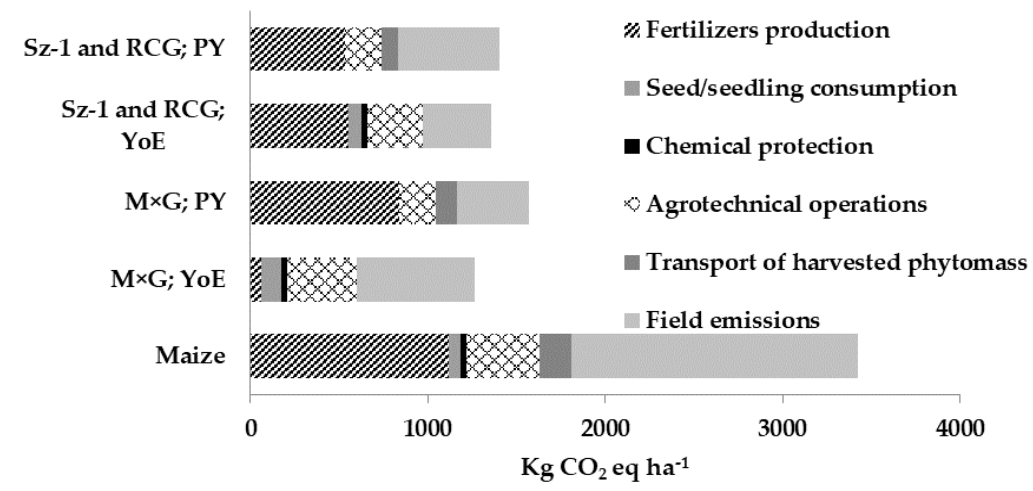
Figure 2. Emissions per area unit. PY = productive year, YoE = year of establishment.